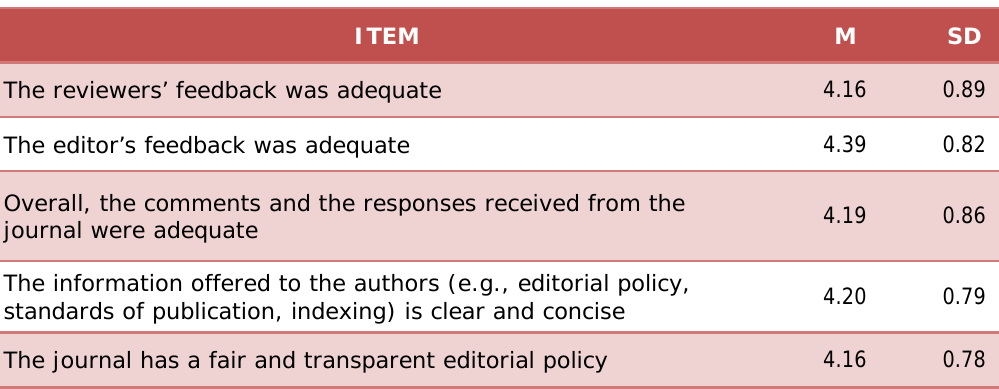
Table 3. “Perception of the authors who have submitted an article in 2008 in relation to